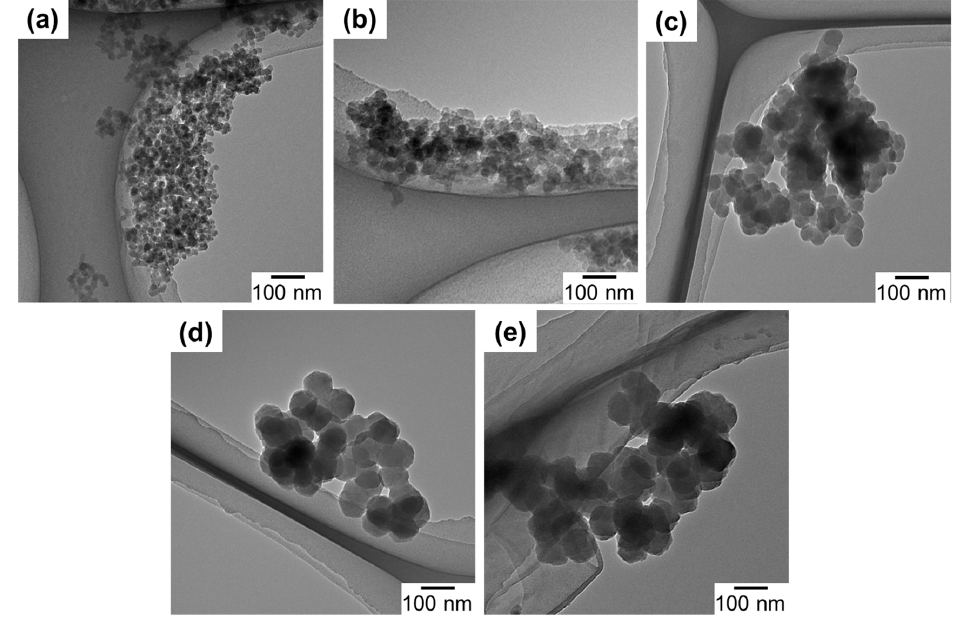
Figure 2. TEM images of UiO-66 nanoparticles: ( a ) UiO1; ( b ) UiO2; ( c ) UiO3; ( d ) UiO4; ( e ) UiO5.